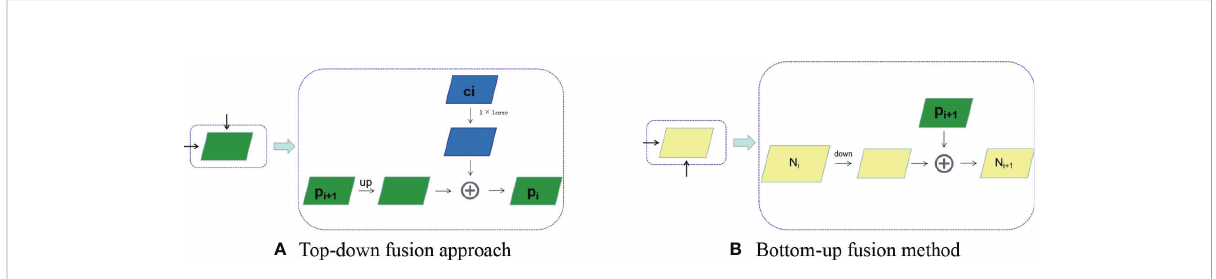
FIGURE 4 FPN connection method ( p i denotes the output of each layer, the income of both (A) and (B) plots are the output of DenseNet